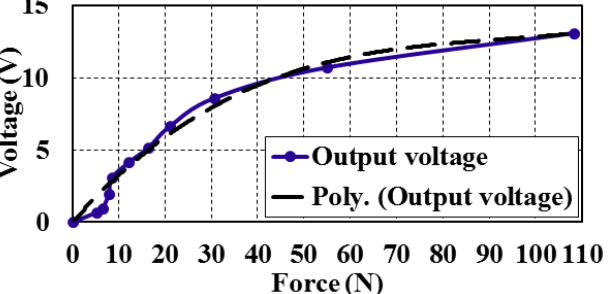
Figure 9. Output voltage of the piezoelectric bimorph versus the applied force showing the regression